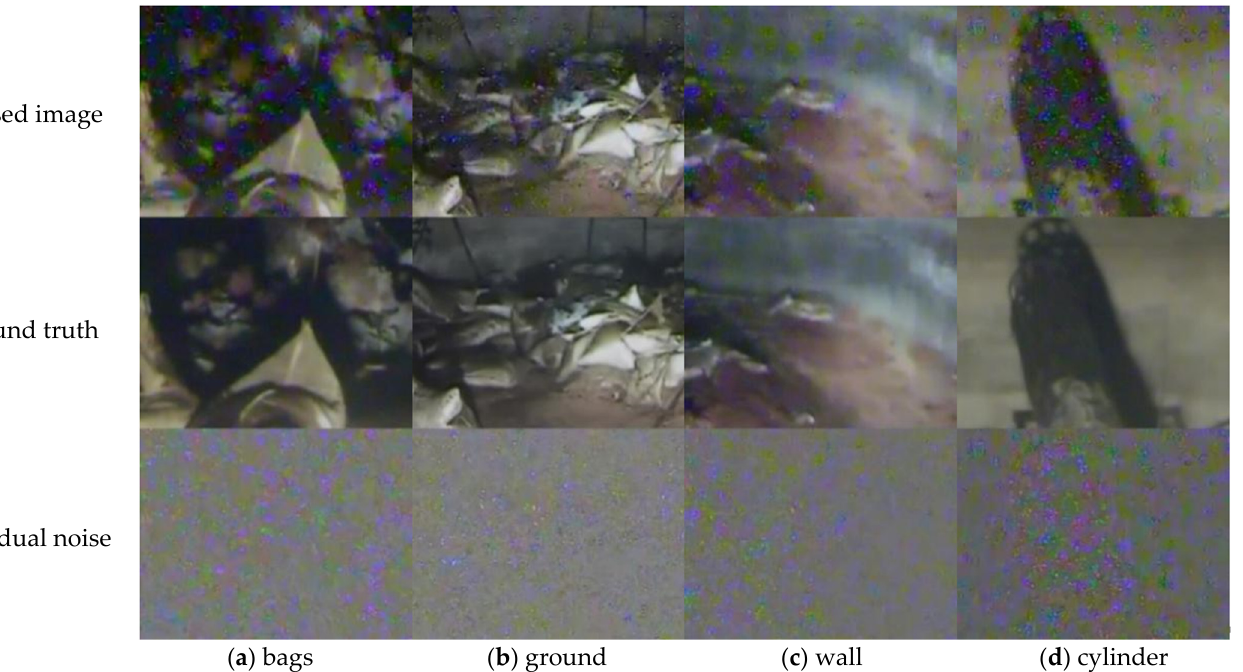
Figure 7. Four scenes of the nuclear radiation dataset. ( a – d ) Show different radiation scenes: bags, ground, wall, and cylinder. The first row shows the original noised images, the second row shows the clean ground truth images, and the third row shows the residual noises.